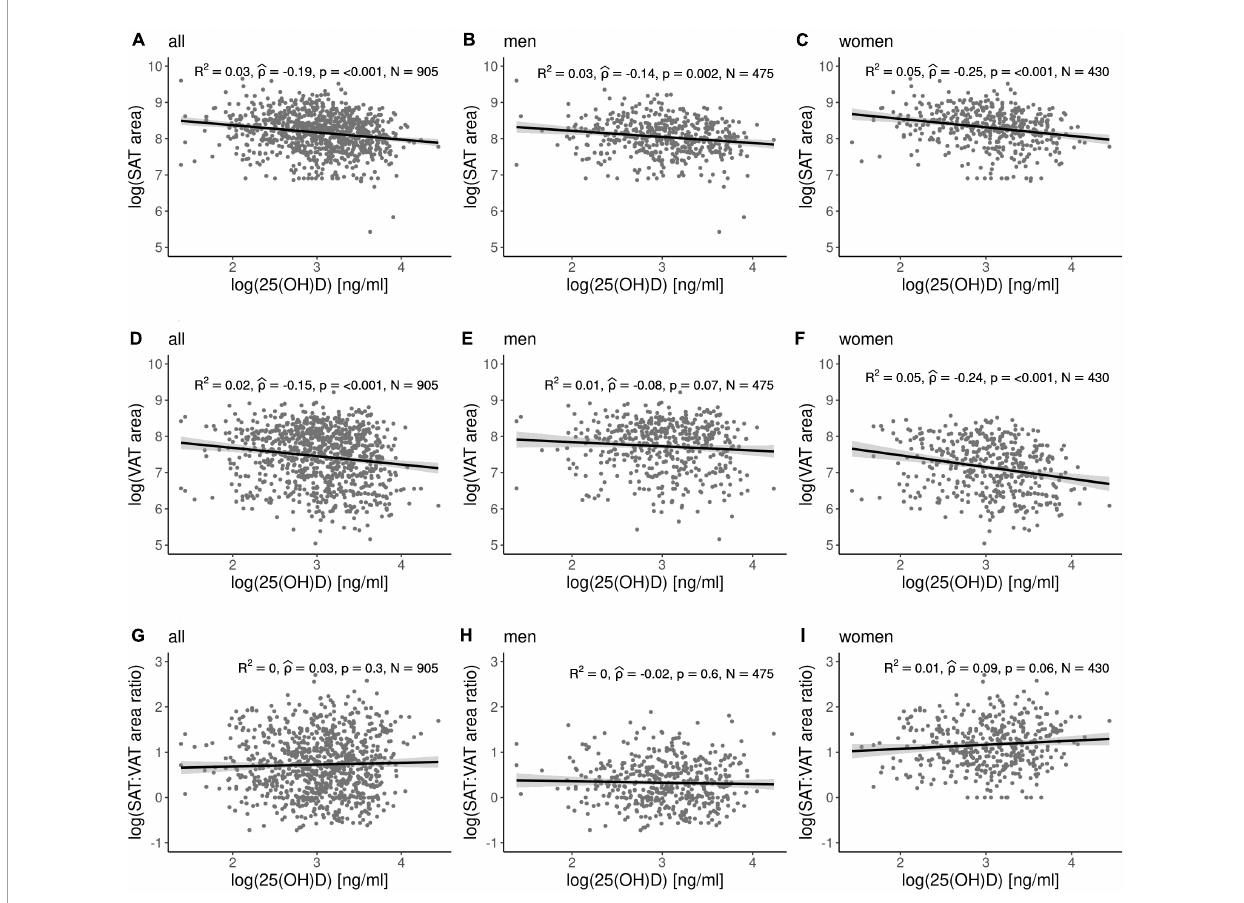
FIGURE2 Correlation analyses between 25(OH)D and fat tissue areas. In LIFE-Adult subcohort significant correlations were observed only in women for 25(OH)D and SAT area (A–C) and VAT area (D–F) . (G–I) No relation was detected between SAT:VAT ratio and 25(OH)D. Fat areas were measured by means of magnetic resonance